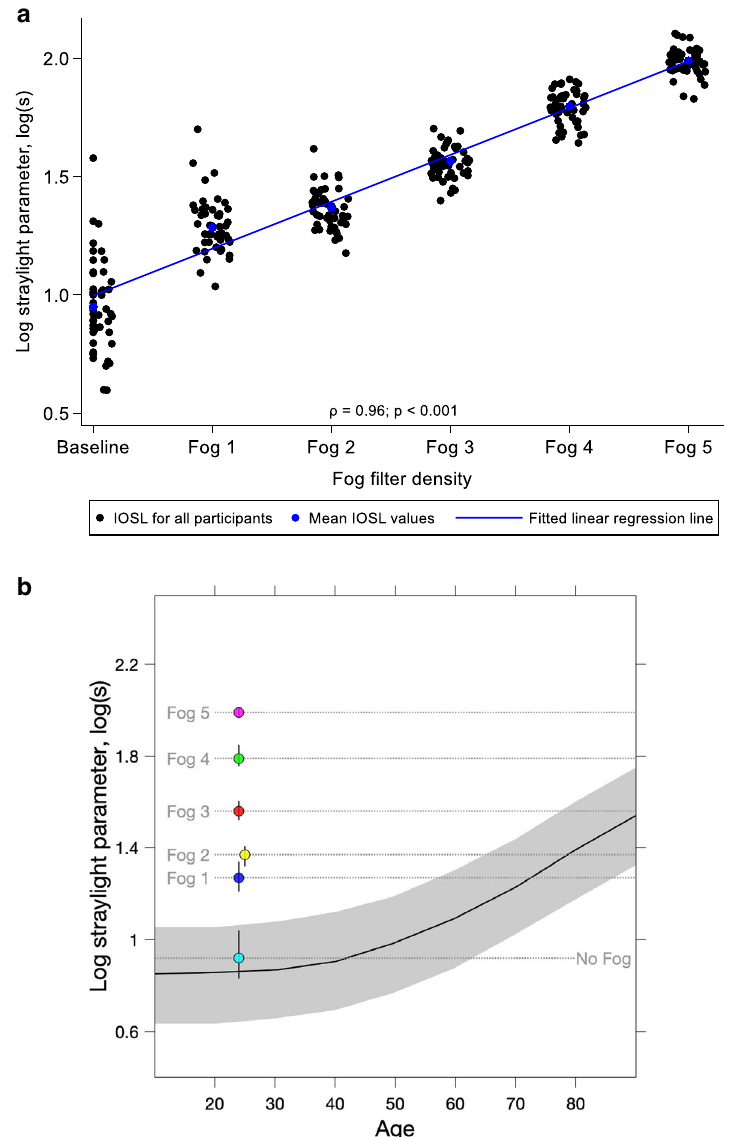
Figure 1. (a) Intraocular straylight (IOSL) values for 47 participants at baseline and under different Fog filter conditions as measured with the C-Quant straylight metre. Spearman’s correlation coefficient (ρ) shows a strong positive and a significant correlation between mean IOSL values and Fog filter density. ( b ) Effect of Fog filters on median IOSL value at baseline and under different Fog filter conditions as measured with the C-Quant straylight meter. Dark curved line = mean IOSL value for each age. Grey band = range (5–95% percentiles) of normative IOSL values for age. Coloured circles = median straylight values for all participants (with ± 1 jitter added where needed to aid visualisation) at baseline and for five Fog conditions, vertical lines = interquartile